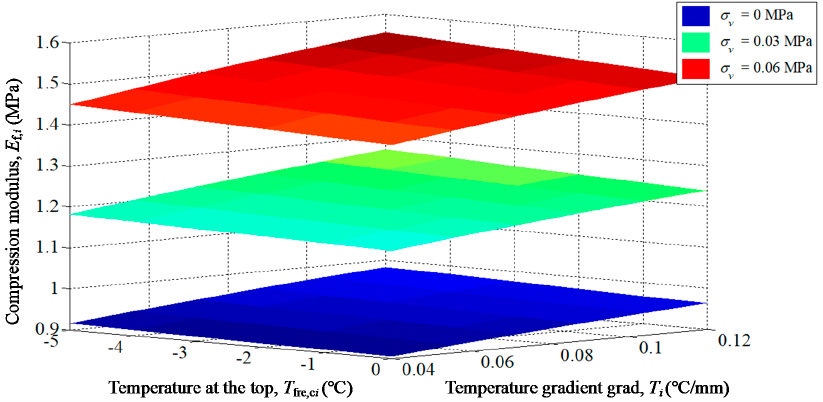
Figure 16. Compression modulus versus vs. temperature gradient and temperature at the top of the i th freezing soil layer under various overburden stresses. i th freezing soil layer under various overburden